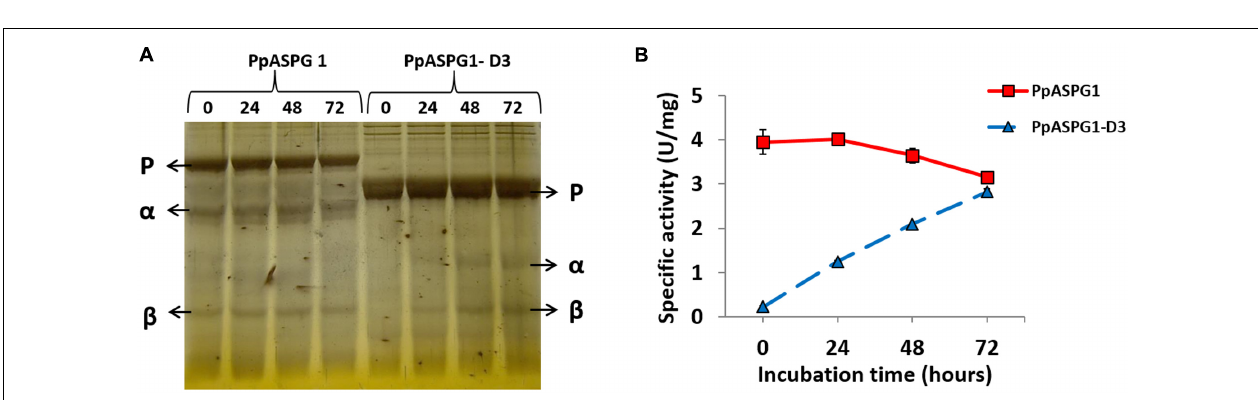
FIGURE 4 | Production of PpASPG1 recombinant proteins in N. benthamiana with different deletions in the variable region. (A) Schematic representation of the different variants of PpASPG1 that were transiently expressed in tobacco leaves. Variants D1, D2, and D3 were expressed as a precursor from which several amino acids in the variable region were deleted, represented by a dashed line. The number of amino acids is included in the colored bars and the theoretical molecular mass corresponding to the precursor and subunits that would result from correct cleavage is indicated on the right. (B) Western blot analysis of the tobacco leaf extracts expressing the different versions of PpASPG1. An antibody against the HA-tag was used and 50 µ g of proteins were loaded in each lane. Protein extract of a leaf that was infiltrated with the empty pJL-TRBO expression vector was also analyzed as a control (C − ). (C) ASPG activity was determined in the protein extracts. Values are the means of three replicates ± SD. All values are significantly different according to t -tests ( p < 0.01).